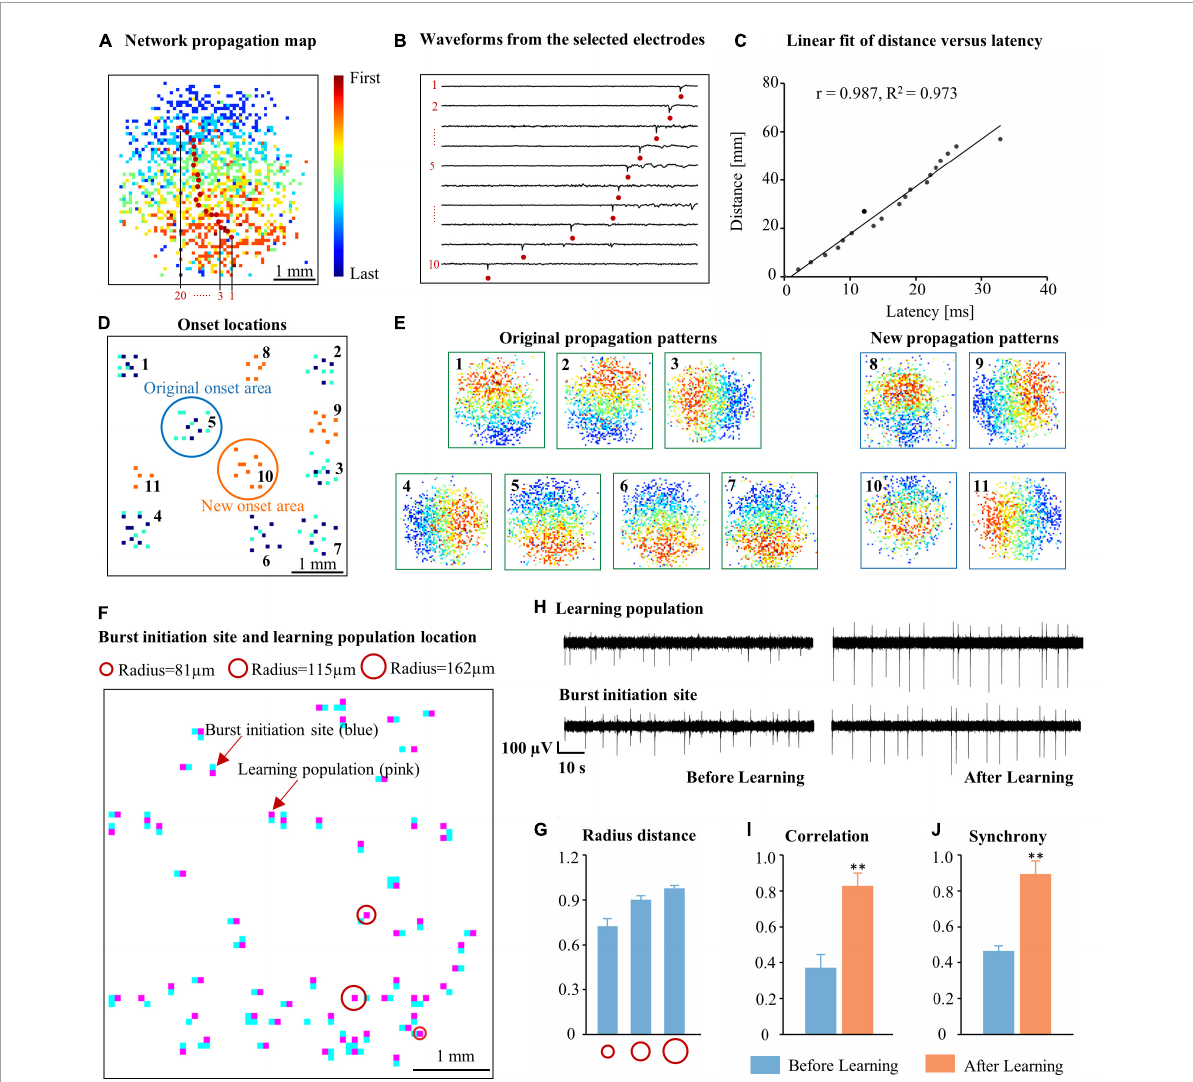
FIGURE4 Initiation and propagation of spontaneous burst activity changed after learning. (A) A typical network burst propagation map. The propagation patterns were revealed by mapping the rank order of the first spike on each electrode during spontaneous synchronized bursts. The propagation pattern from the initial regions of the burst to outside of the area is marked with red dots. Color codes indicate the rank order of the first spike on each electrode during spontaneous bursts. (B) Waveforms from the first selected 10 electrodes in (A) . (C) Linear regression of distance vs. latency for the selected electrodes in (A) . (D) Representative diagram of the distribution of burst onset in a culture within 5 min before and after learning (blue dots: before learning, orange and cyan dots: after learning). The representative original burst onset area is circled in blue, and the new onset area is circled in orange. (E) Representative burst propagation pattern in each burst area (the number code follows that in D ). (F) The distance between the burst initiation site and location of learning populations (for 67 burst initiation sites). (G) The distances between the burst initiation sites and the learning populations from (F) . (H) Raw voltage recording of burst initiation sites and learning populations before and after learning. The correlation (I) and synchrony (J) between burst initiation sites and learning populations (time = 60 s, n = 5 cultures. ∗ p < 0.05 vs. Cycle 1, ∗∗ p < 0.01 vs. Cycle